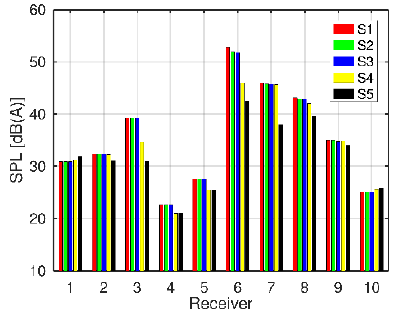
Figure 10. Noise level in each receiver at 1.5 m—Lday with all noise sources .